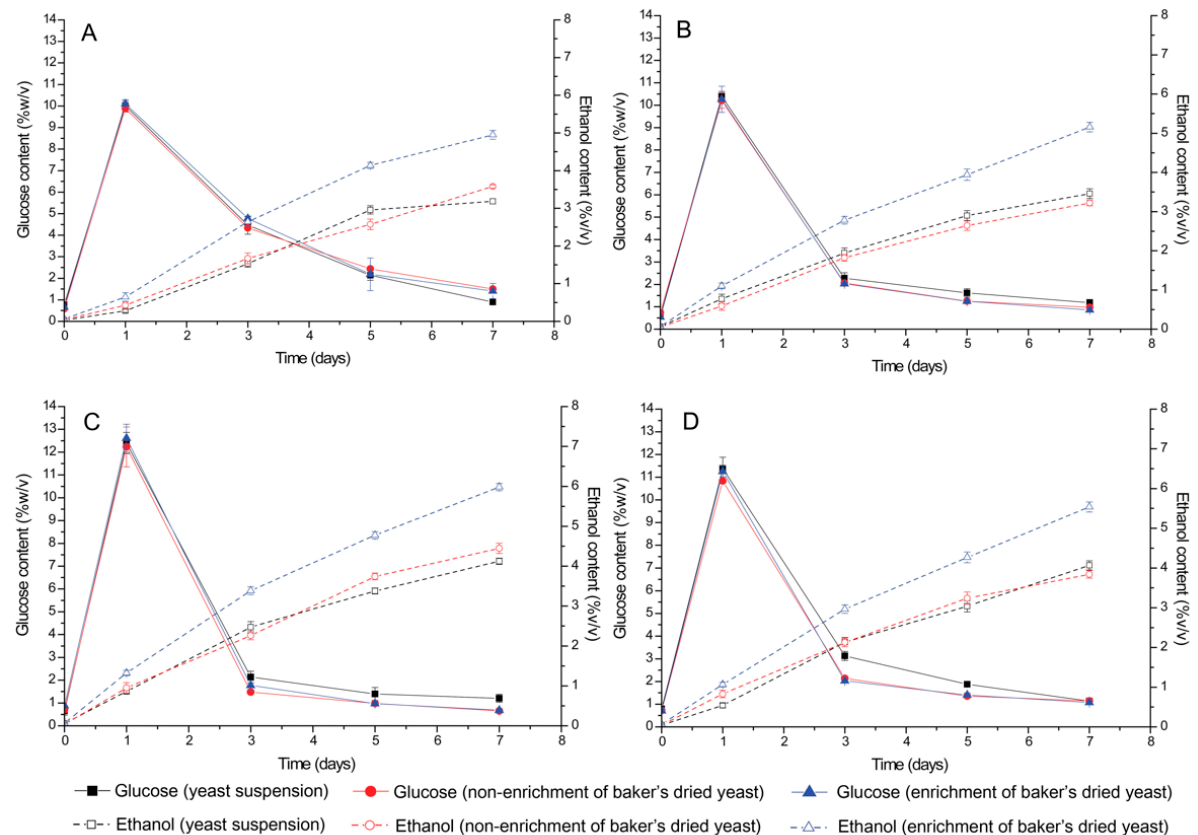
Figure 1. Alcohol fermentation from polished rice ( A ), black fragrant rice ( B ), glutinous rice ( C ) and black glutinous rice ( D ) with various starter cultures.